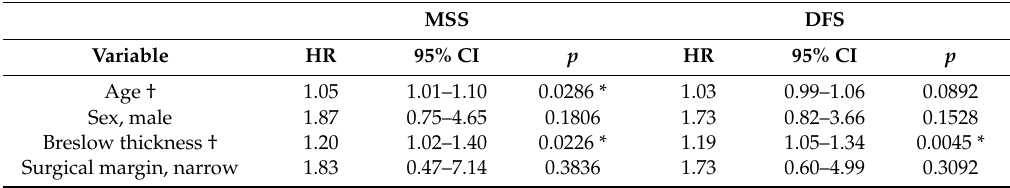
Table 6. Cox multivariate analysis for melanoma-specific survival (MSS) and disease-free survival (DFS).